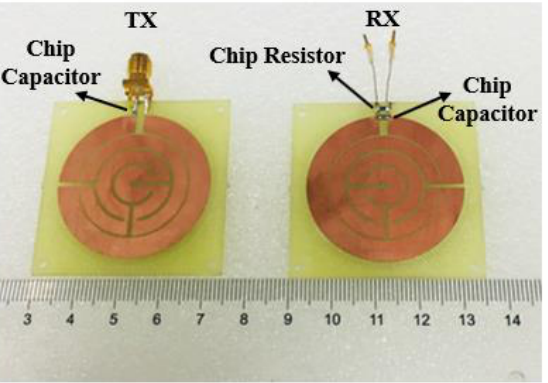
Figure 12. Fabricated wireless power link with proposed four-turn split-ring loops.